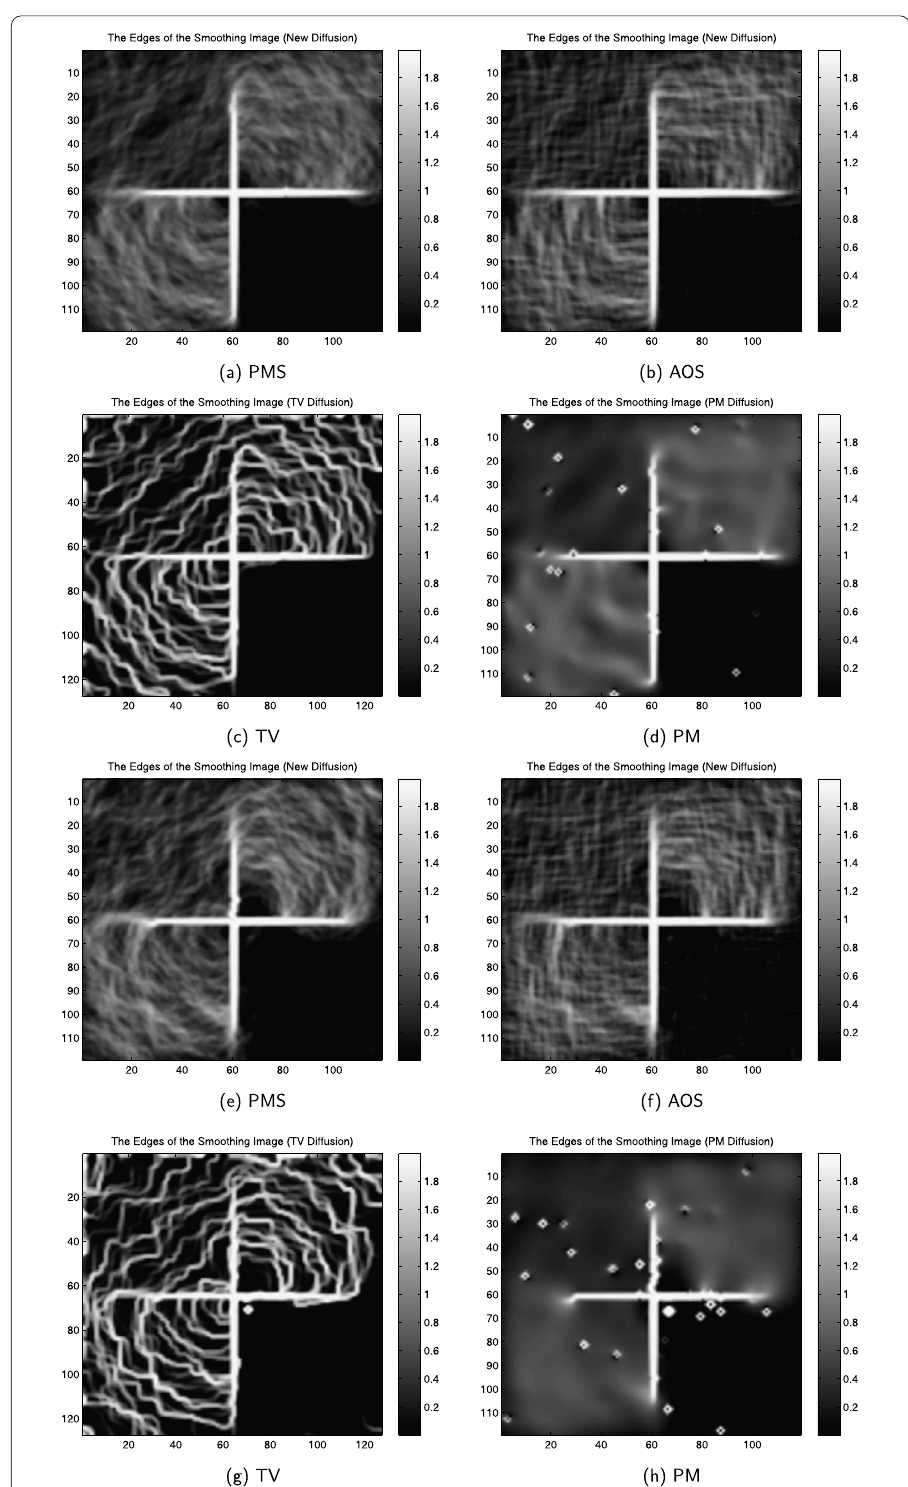
Figure 3 The edge indicator function. ( a )–( d ) The edge indicator functions for the denoising results of every methods when σ = 30; ( e )–( h ) The edge indicator functions for the denoising results of every methods when σ =